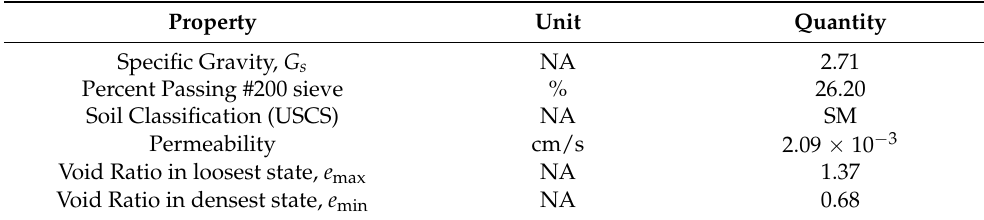
Table 1. Properties of Saemangeum dredged soil used in the shaking table test.